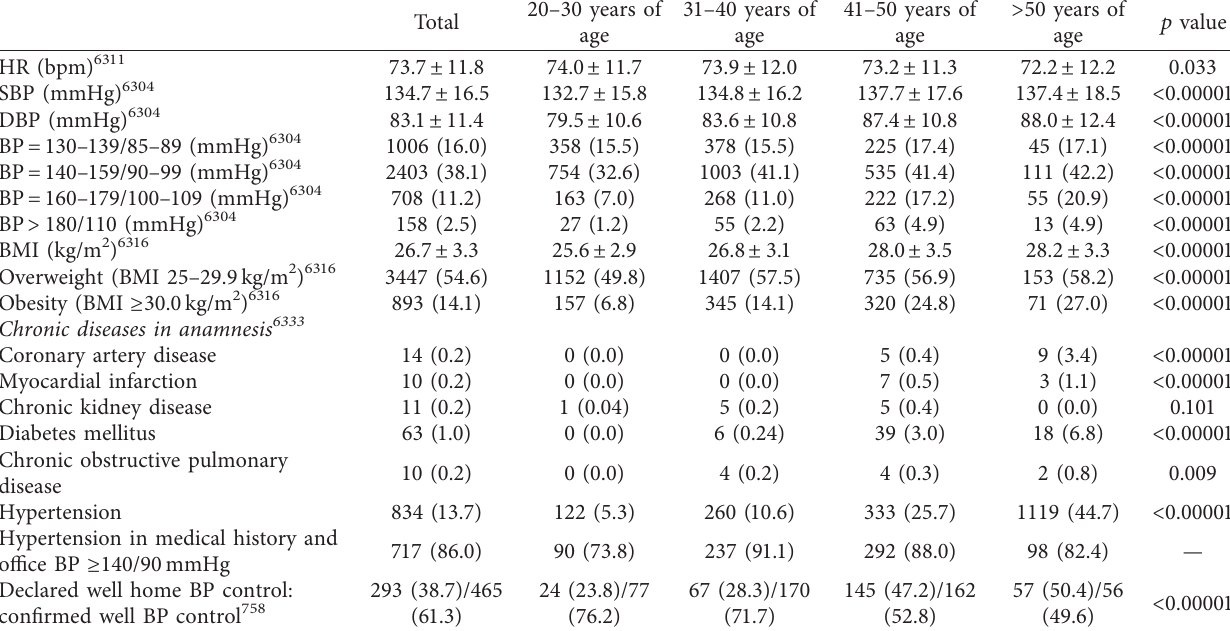
Table 2: Basic clinical